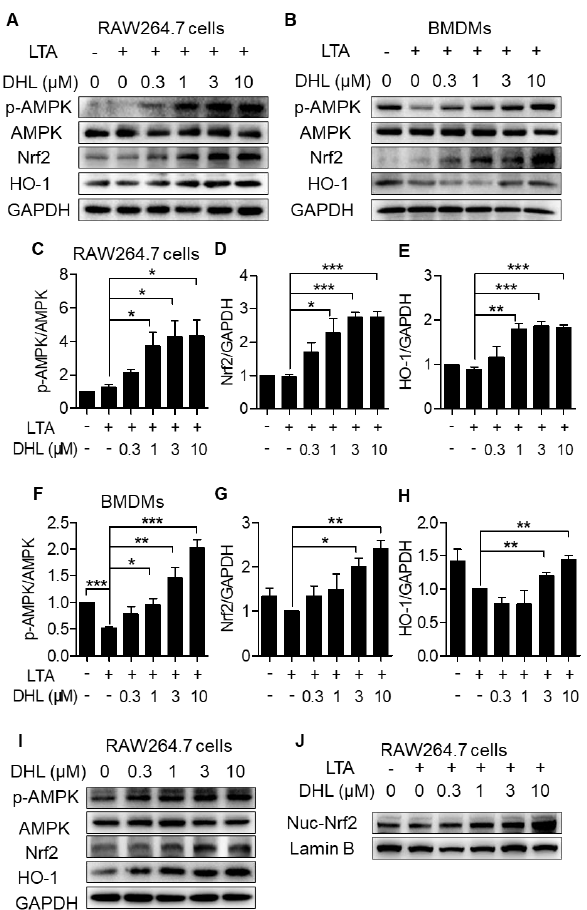
Figure 2. The AMPK/Nrf2 pathway is involved in DHL–mediated macrophage activation by LTA stimuli. RAW264.7 cells ( A , C – E ) and BMDMs ( B , F – H ) were preincubated with the indicated con- centration (0, 0.3, 1, 3, and 10 μM) of DHL for 0.5 h, followed by LTA (20 μg/mL) stimulation for 0.5 h. ( A , E ) Cell lysates were prepared for Western blot analysis and the expression of p-AMPK, AMPK, Nrf2, and HO-1 were detected, with GAPDH used as the loading control. The ratios of p- AMPK/AMPK ( C , F ), Nrf2/GAPDH ( D , G ) and HO-1/GAPDH ( E , H ) were analyzed by ImageJ soft- ware. ( I ) RAW264.7 cells were treated with different concentrations (0, 0.3, 1, 3, and 10 μM) of DHL for 0.5 h. Then, cell lysates were prepared to detect the expression of p-AMPK, AMPK, Nrf2, and HO-1, with GAPDH used as the control. ( J ) RAW264.7 cells were pretreated with DHL (0, 0.3, 1, 3, and 10 μM) for 0.5 h, followed by LTA stimulation for another 0.5 h. Nuclear fractions were ex- tracted and subjected to immunoblot analysis using Nrf2 and Lamin B antibodies. Data are repre- sented as mean ± SEM, n = 3, * p < 0.05, ** p < 0.01, *** p < 0.001.